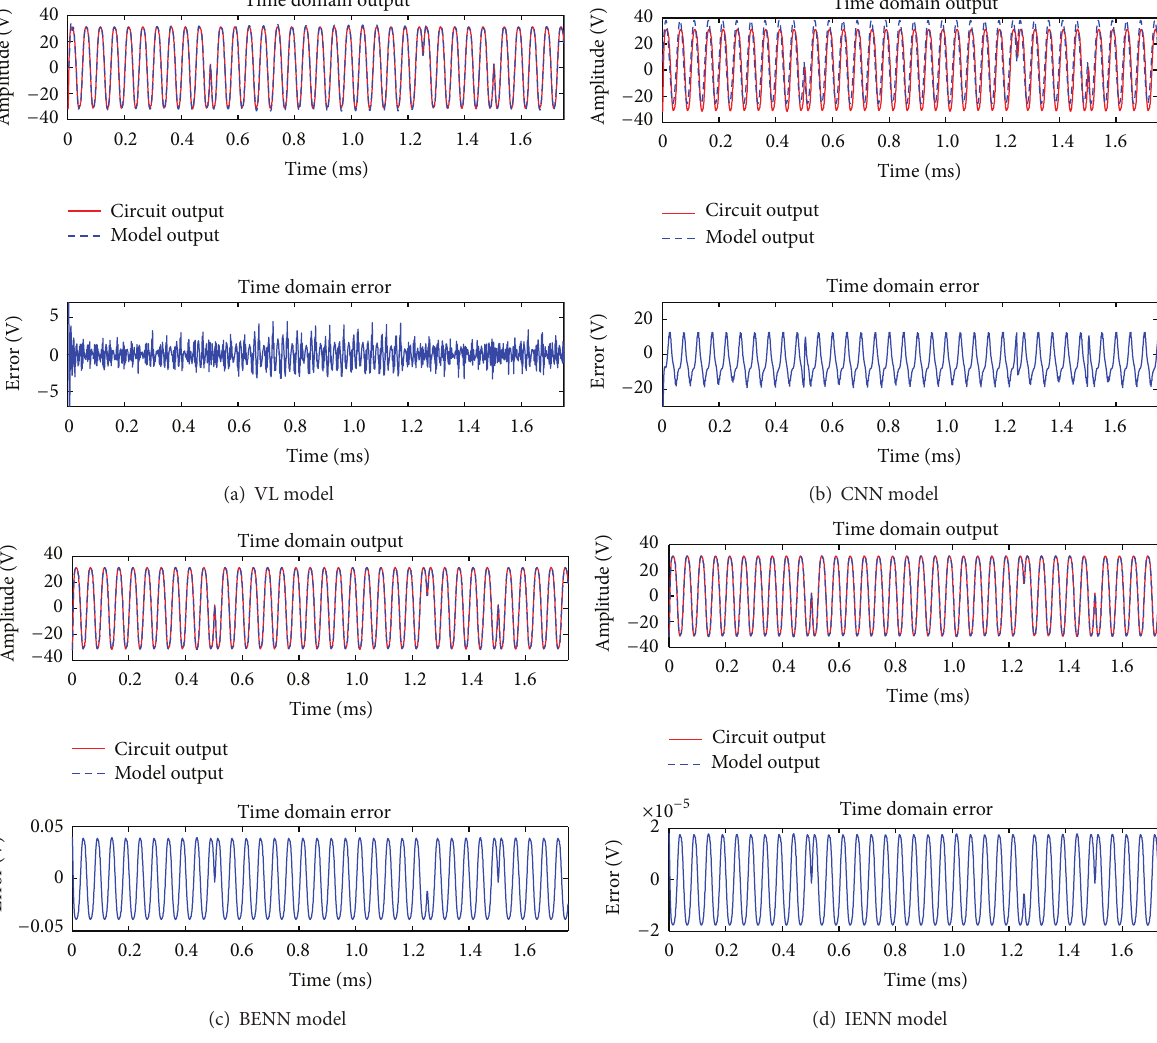
Figure 9: Comparison among four behavioral models in time domain with 2PSK signal input. Table 5: Mean error 𝜎 and maximum transient error 𝜎 max of four behavioral models with 2PSK signal